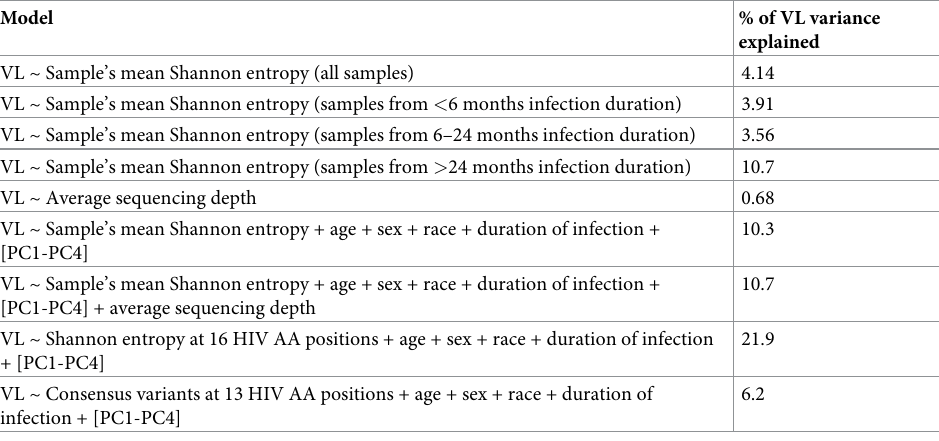
Table 2. Variance in viral load (VL) explained by linear regression analysis with different models. PC1-PC4 denote first four principal components of principal component analysis performed on consensus AA variants to account for the viral population structure. The 16 and 13 HIV AA positions are all positions significantly associated with VL when position-wise Shannon entropy or consensus variants, respectively, are used to explain